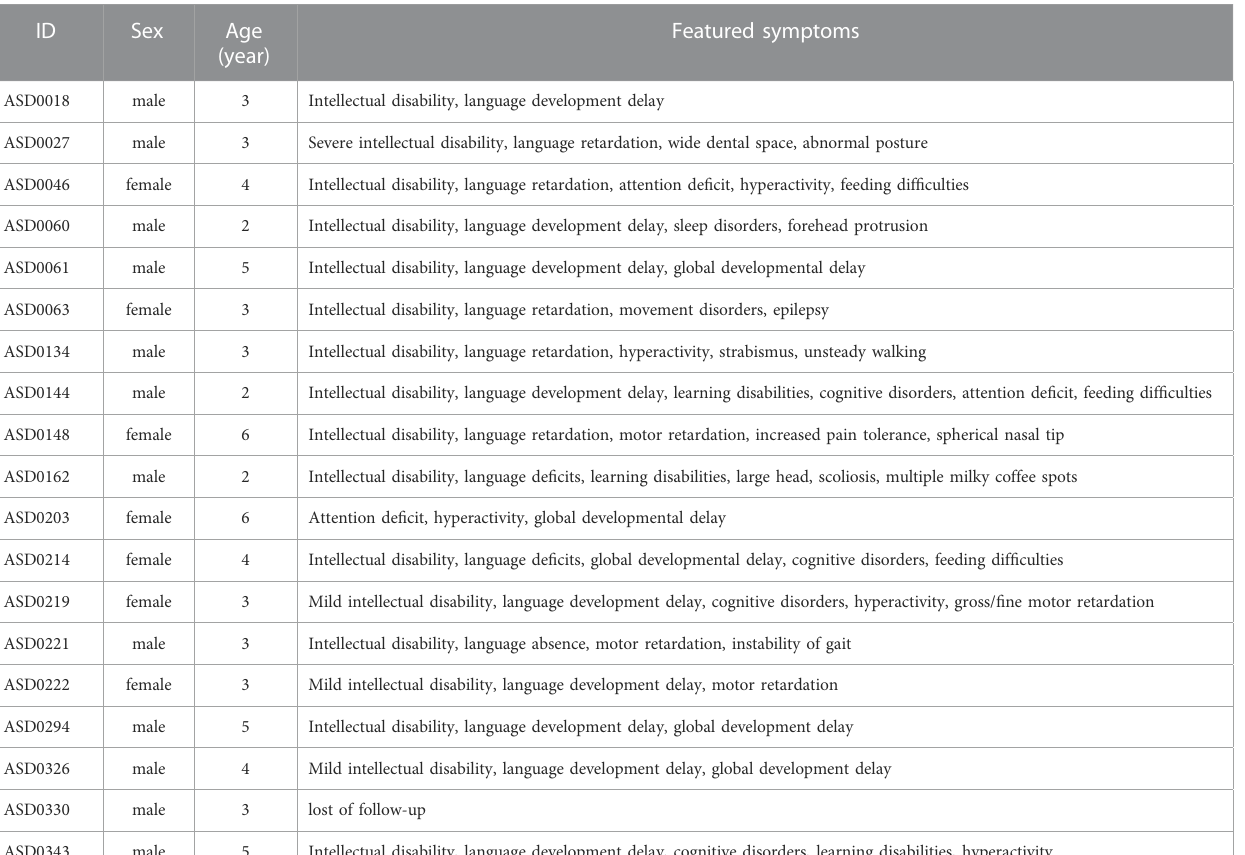
TABLE 1 Clinical features of 19 diagnosed ASD